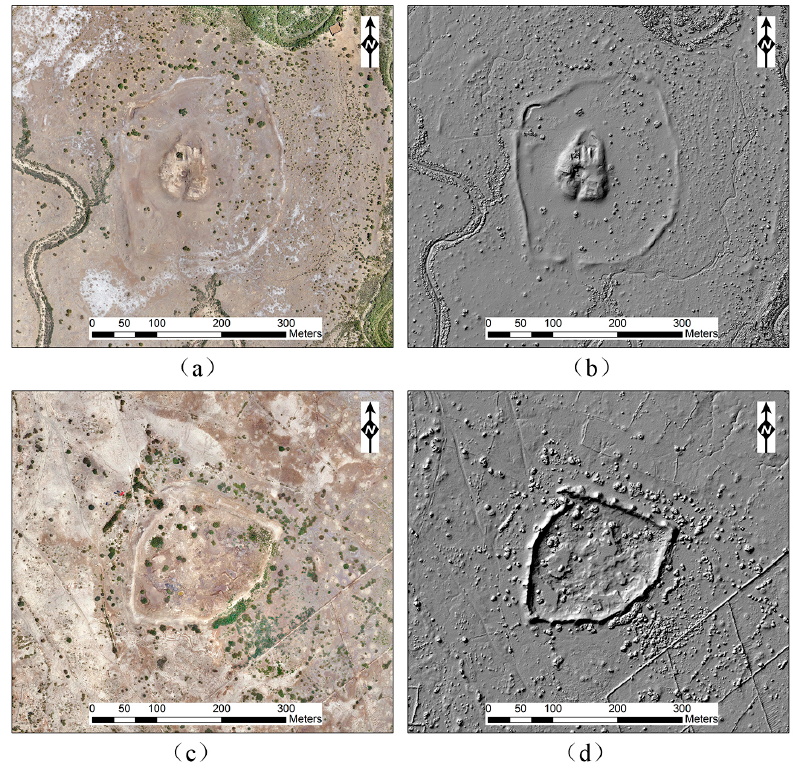
Figure 12. ( a ) Multispectral and ( b ) hillshade imagery of Kuyux Shahr (C15); ( c ) Multispectral and ( d ) hillshade imagery of Kuhne Shahr (C16). They are from aerial photos by unmanned aerial vehicle (UAV) in 2016.